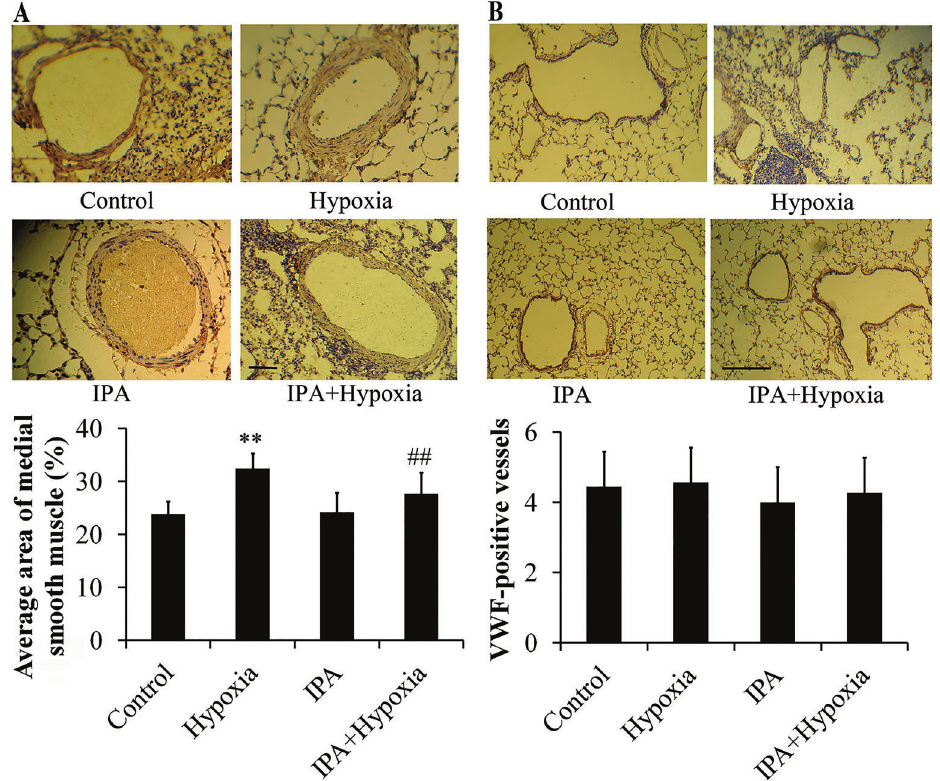
Figure 2. Effects of inactivated P. aeruginosa (IPA) on vessel thickness ( A ) and density ( B ), assayed by immunohistochemistry (n=6). The thickness of the arteries in chronic hypoxia rats was signi fi cantly increased compared to control rats. IPA markedly attenuated this effect (magni fi cation (cid:1) 400). **P o 0.01 vs control; ## P o 0.01 vs hypoxia (ANOVA). The density of blood vessels, addressed by immunostaining of the von Willebrand factor (vWF), was not different between groups (magni fi cation (cid:1)